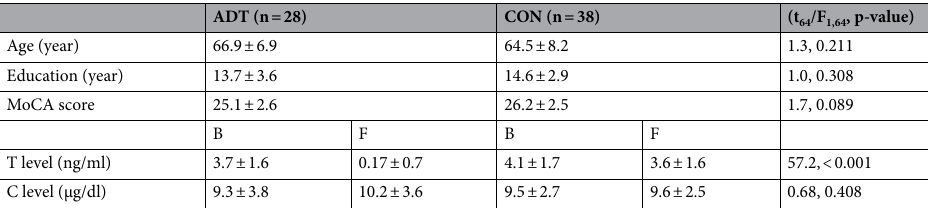
Table 1. Demographic and clinical characteristics of the patients. MoCA Montreal Cognitive Assessment, T testosterone, C cortisol, B baseline; F follow-up. For T and C levels, the statistics (F 1,64 , p-value) correspond to treatment × time interaction, while for the other variables the statistics (t 64 , p-value) correspond to two-sample t-tests comparing ADT and CON at the